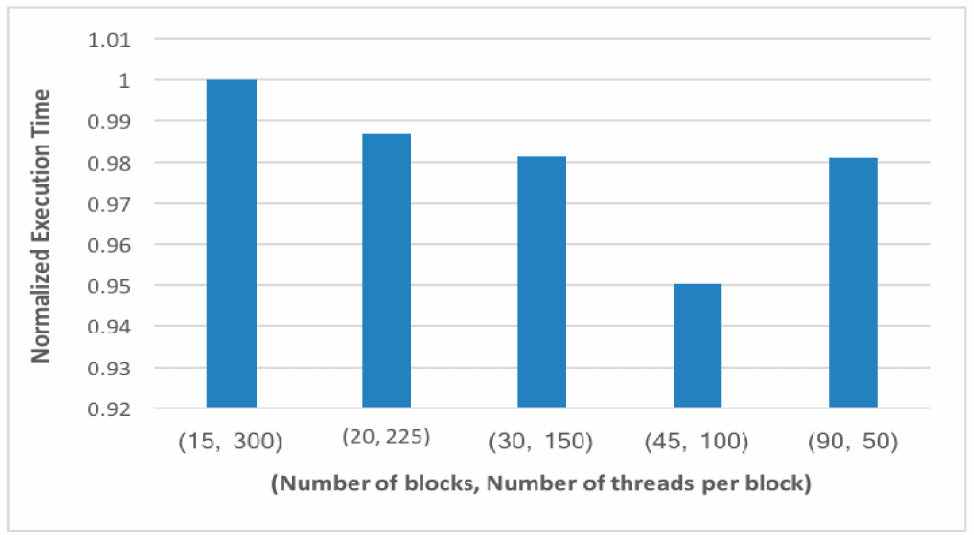
Figure 15. Comparison of normalized execution time for various combinations of number of blocks and number of threads per block. The number of blocks is equal to the number of islands. The number of threads per block is equal to the product of the number of chromosomes and the number of genes per chromosome. In this comparison, five chromosomes are migrated per